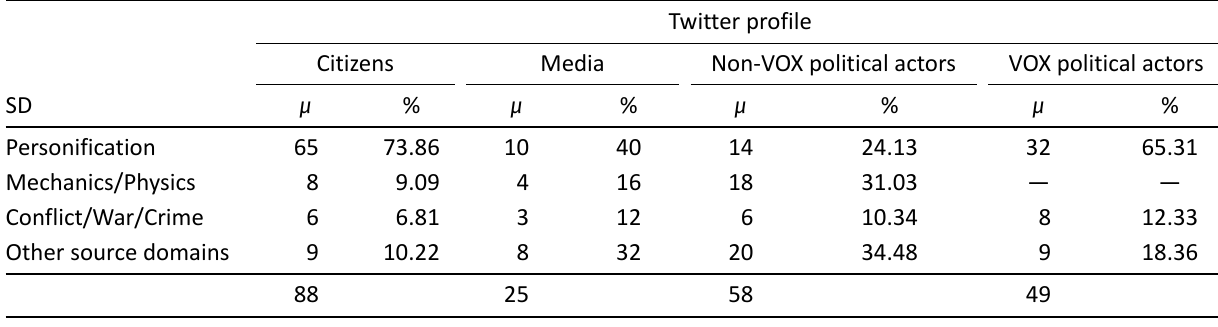
Table 6. Source domains used by Twitter profile to refer to the people.